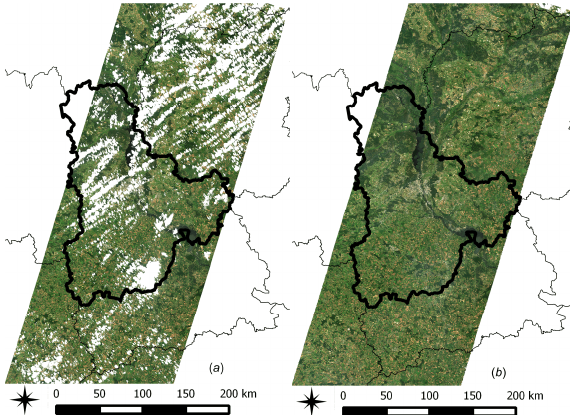
Figure 2. Example of restoration of missing data in Landsat-8 images acquired on the 5th of July 2013. Original image with identified clouds and shadows as missing data is show in (a). Result of restoration is shown in (b). For both images true colour composite of bands 4-3-2 is shown. SR reflectance values are scaled from 0 to